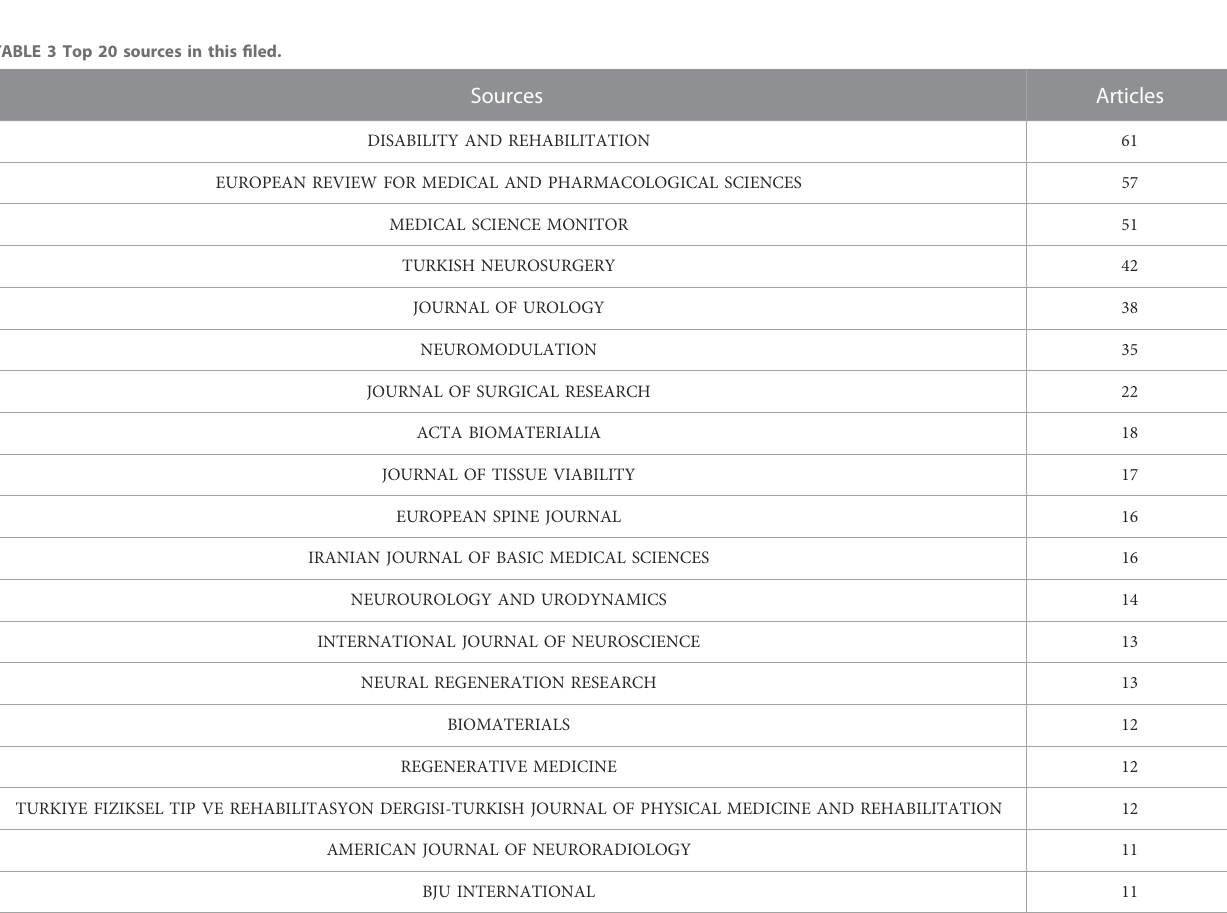
TABLE 3 Top 20 sources in this fi led. Sources